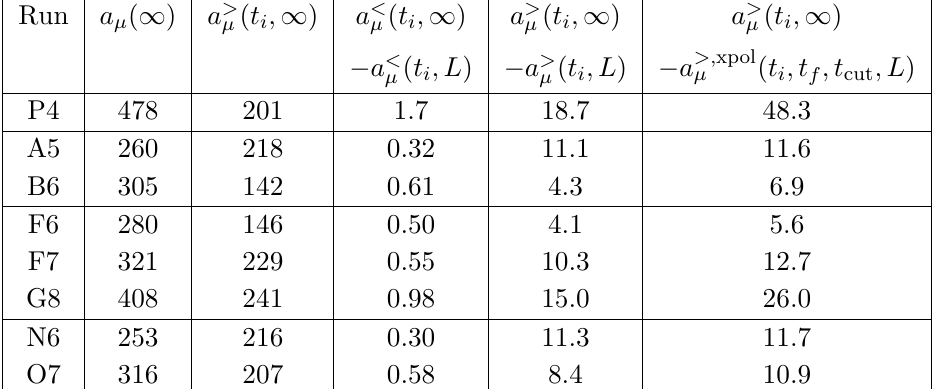
in the TMR in units of 10 (cid:0) 10 , based on (cid:22) and on the Gounaris-Sakurai model (cid:22) . (cid:22)